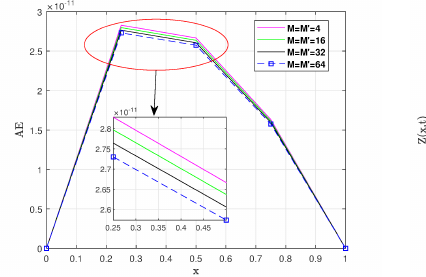
Figure 3. The AE functions of applying the proposed method with m = m ′ = 1, η = η 1 = 1 and different values of 2 M = M ′ in Example 1.